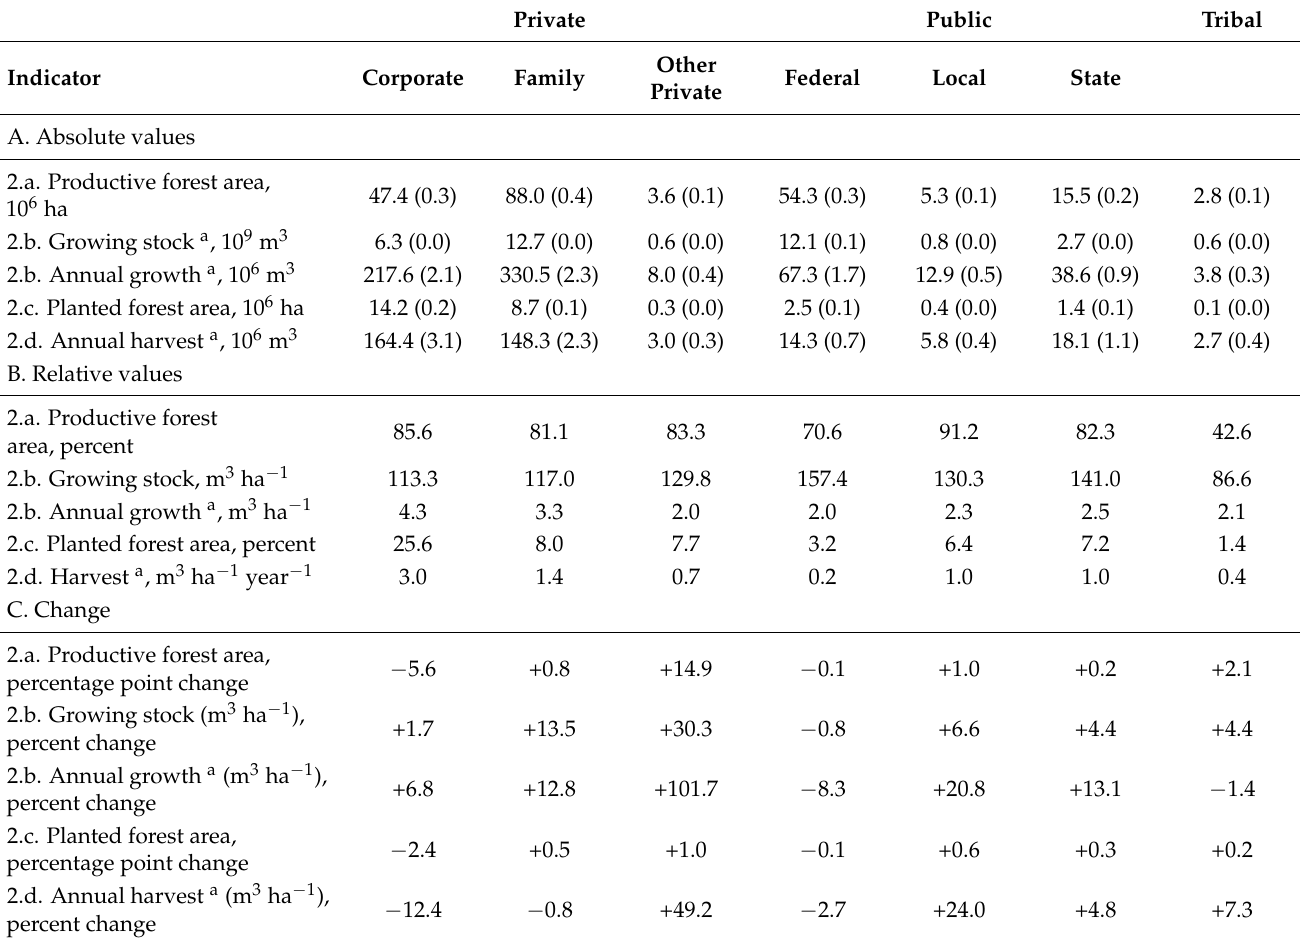
Table 4. Summary of selected Montr é al Process Criterion 2 Indicators by ownership category, conterminous USA in terms of: (A) absolute values (2019), (B) relative values (2019), and (C) change (2012–2019). Indicators, including data sources, are described in Table 1. Where available, standard errors are listed parenthetically following the